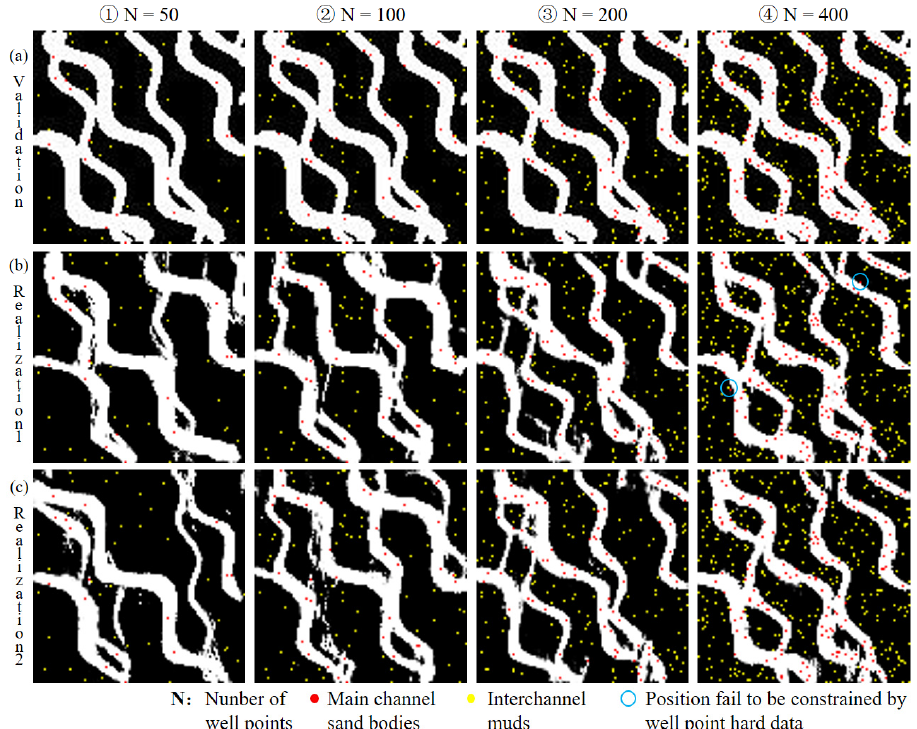
Figure 11. Results of conditional modeling of stationary problem (meandering river main channel sand bodies). ( a ) The validation model; ( b ) a group of realizations constrained by different number of well points; ( c ) another group of realizations constrained by different number of well points.